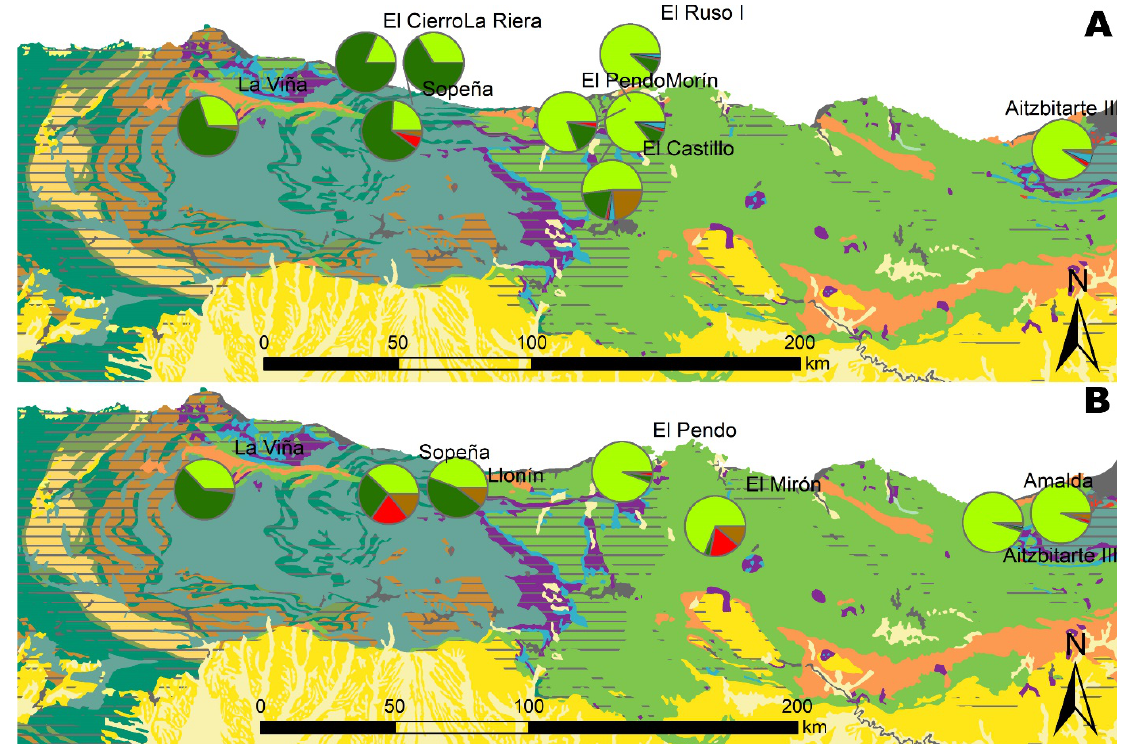
Figure 8. Raw material distribution at each archaeological site during the Solutrean (above) and the Magdalenian (below) using pie charts. Main chrono-lithological strata in the Cantabrian Region are displayed, based on a 1:1.000.000 geological map (Álvaro et al. 1994). Lithology colours are the same as for Figure 1. Pie chart colours are also the same as in Figure